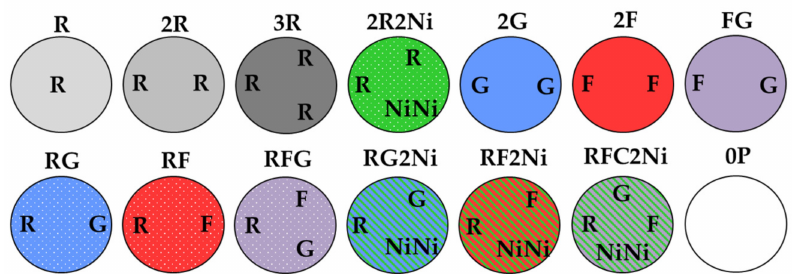
Figure 1. Number of individuals per mesocosm and code of each species in each treatment. R: OSR ( Brassica napus L. cv Avatar), F: Faba bean ( Vicia faba L. cv Fanfare), G: Grass pea ( Lathyrus sativus L. cv Merkur) and Ni: Niger ( Guizotia abyssinica (L.f.) Cass.). Each of these ab- breviations is an individual plant. 0P: No